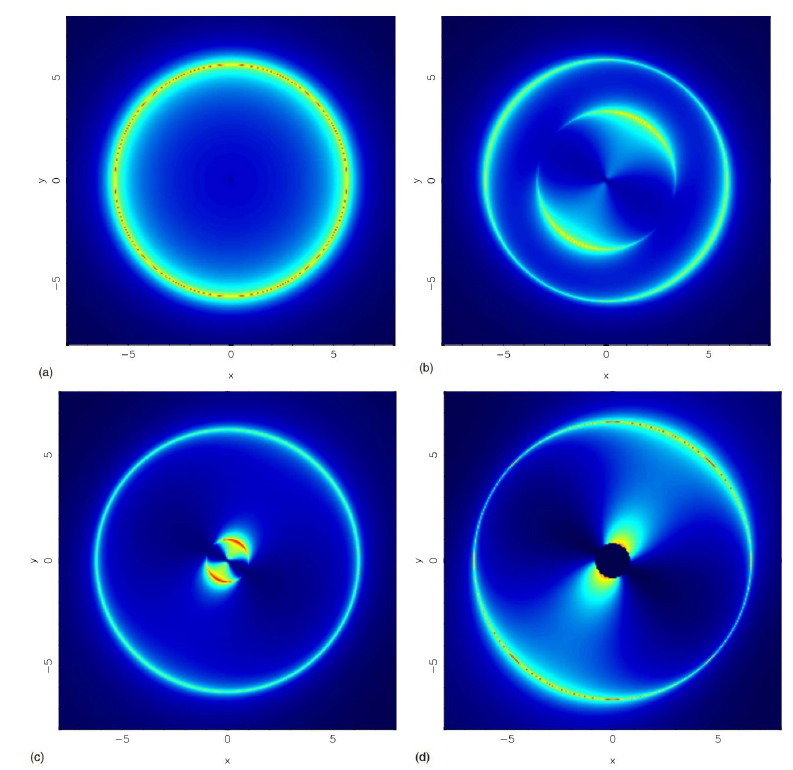
Figure 7. Almost similar to Figure 5, variation is observed because the strain applied field is θ = π /6. Reprinted with permission from [38]. Copyright (2010) American Physical Society.